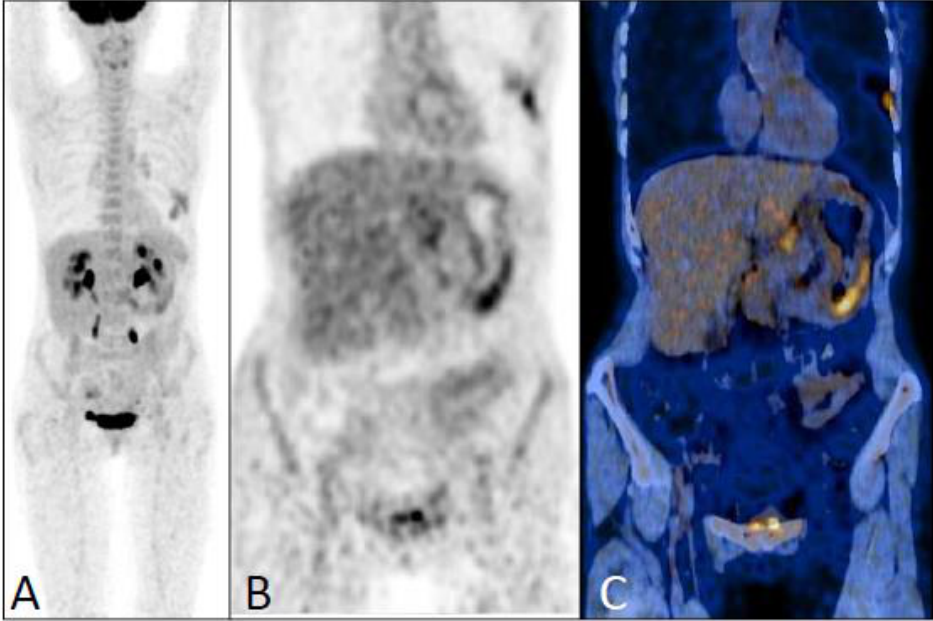
Figure 2. An FDG-PET/CT scan performed one year after the initial diagnosis of ILC (pT1bN0, SBR II, Ki67 = 30%) in a 56-year-old patient treated by aromatase inhibitor, due to a pyloric ulcer. Low increased FDG uptake in the thickened gastric wall was demonstrated on the maximum intensity projection ( A ), coronal PET ( B ), and PET/CT fusion ( C ) images. The increased uptake in the left lower chest was related to a pneumonitis. This patient died nine months later from disease progression of gastric